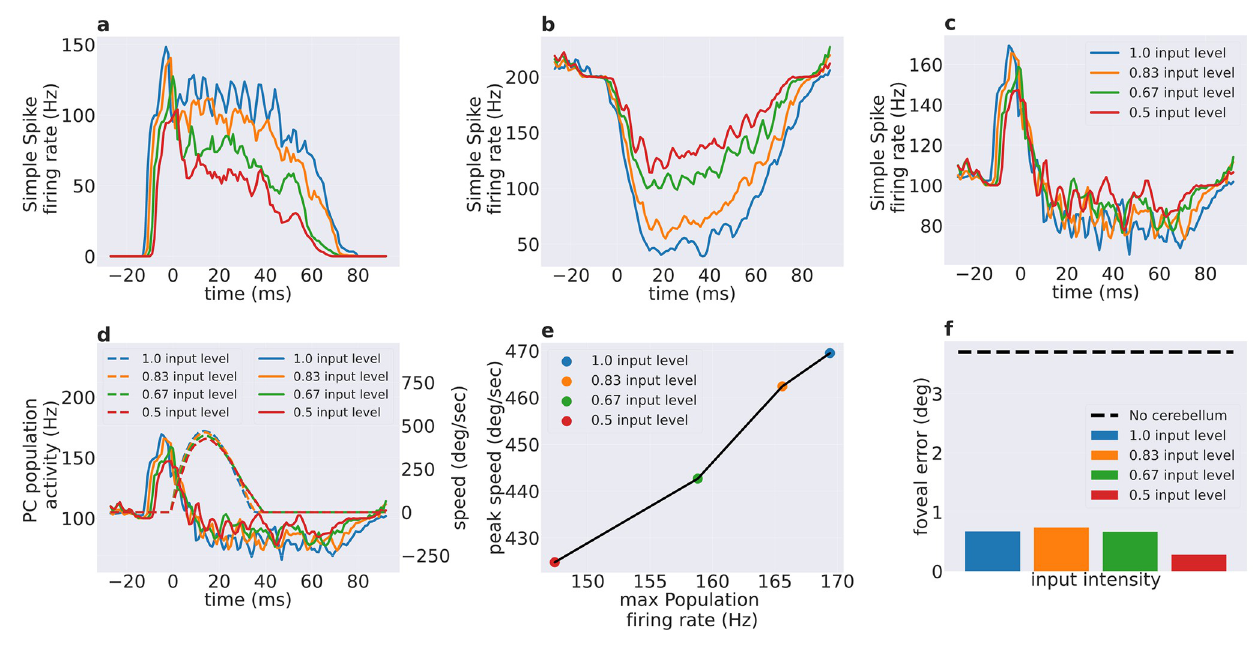
Fig 4. Predictive encoding of saccade eye speed in PC activity. Modulation of simple spike firing rate caused by decreased input on the cerebellar MFs (1, 0.83, 0.67 and 0.5 of the input used for training) for a) the burst PC subpopulation, b) the pause PC subpopulation, and c) for all PCs together (t = 0 ms is the onset of the eye movement). d) Comparison of PC population activity and saccade eye speed (dashed lines) for different MF input levels. e) Relationship between the peak of PC SSpike firing rate in the anticipatory period and the corresponding peak eye speed. Pearson correlation = 0.99, p value < 0.01. f) The foveal error occurring at the different input levels to the cerebellar network. The dashed black line corresponds to the foveal error without the cerebellum.